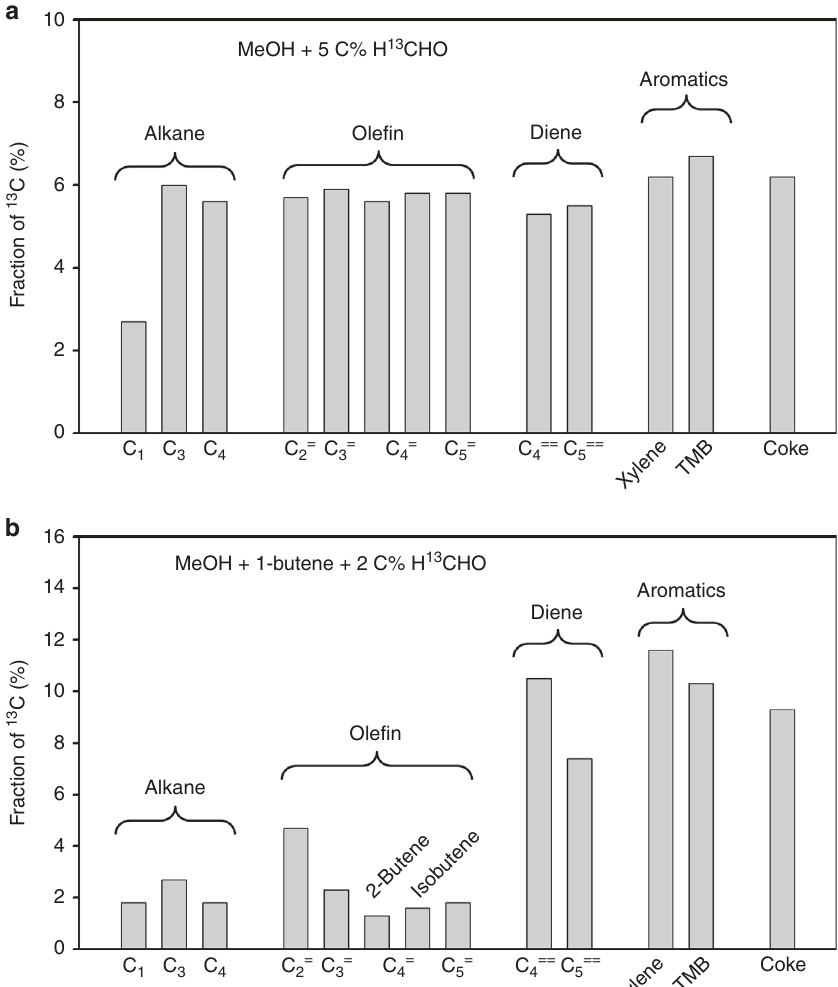
Fig. 5 Fraction of 13 C in hydrocarbon products in the reaction of MeOH cofed with H 13 CHO. a MeOH cofed with 5 C% H 13 CHO, MeOH conversion 75%. b MeOH cofed with 1-butene and 2 C% H 13 CHO; MeOH conversion 100%, butene decreased from 57% in the feedstock to 24% in the gas products. C 2 = , C 3 = , C 4 = and C 5 = refer to ethene, propene, butene and pentene, respectively; C 4 == and C 5 == refer to butadiene and pentadiene respectively.